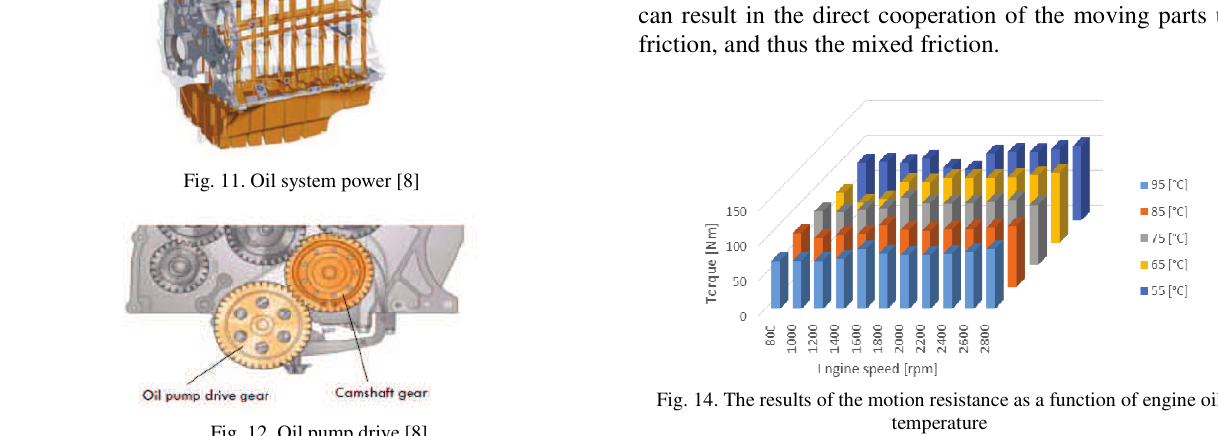
Fig. 14. The results of the motion resistance as a function of engine oil